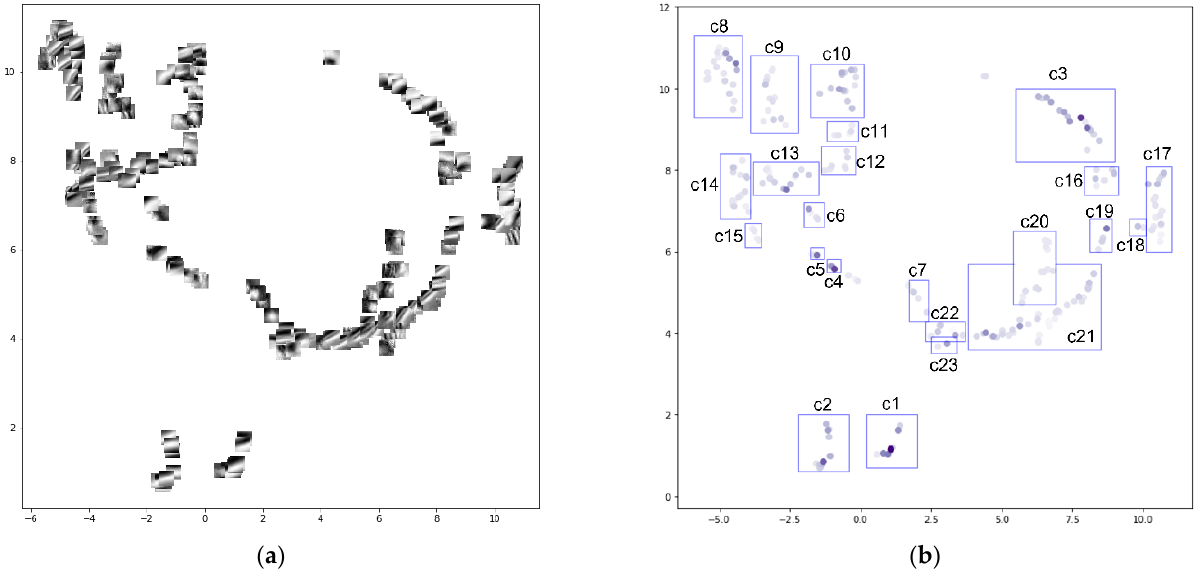
Figure 7. ( a ) Visualisation of 256 bases from the “0_0” dictionary as embedded by UMAP. ( b ) Distribution of clusters of bases on the embedded space by UMAP. The colour shading of the symbols on ( b ) corresponds to the sum of the absolute values of the coefficients of each basis in the reconstruction. “c1” represents “cluster 1”, and the same applies to “c2” and beyond.